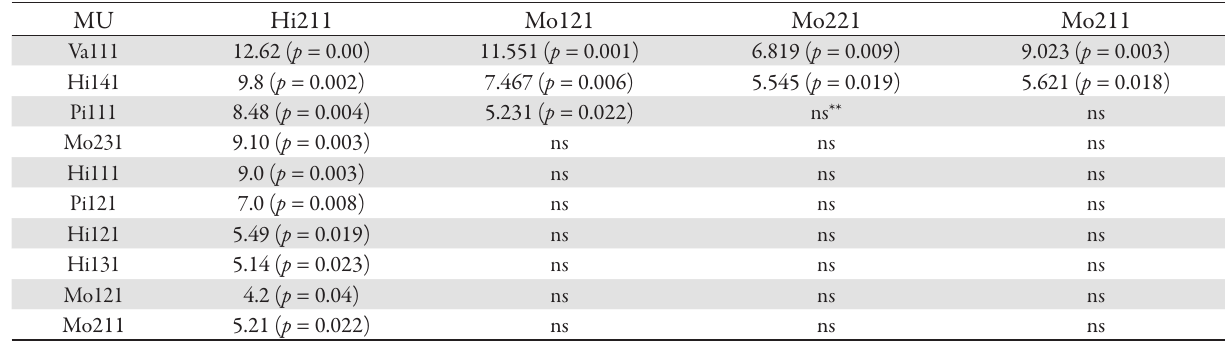
Tab. 2. Multiple comparison between percentage cover of vegetation and geopedologic map units*